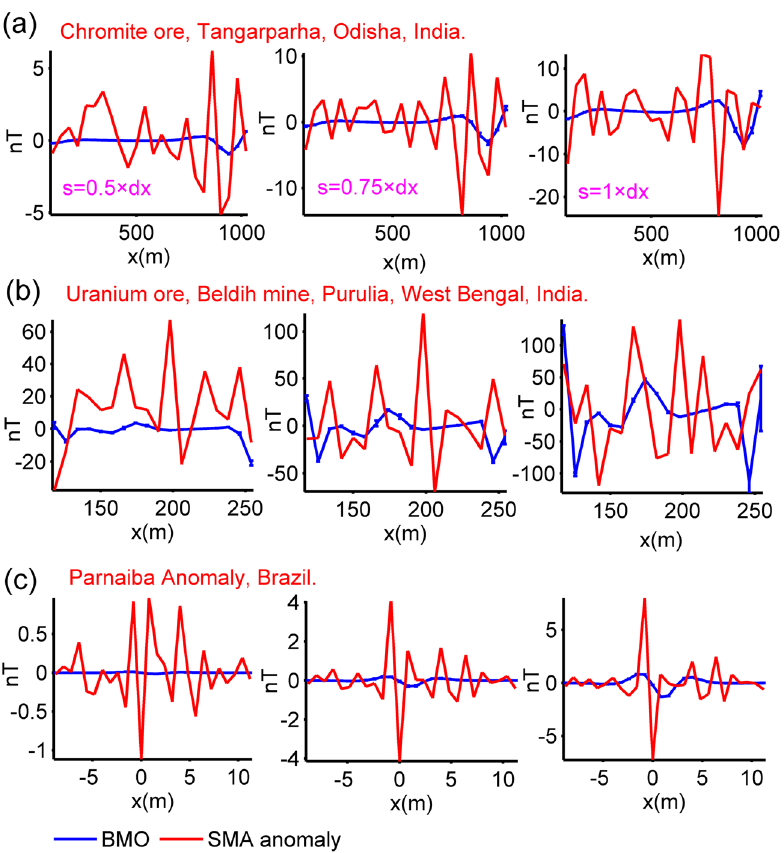
Figure 17. Inversion results of three field cases obtained via BMO with the implementation of the SMA technique, ( a ) the calculated SMA magnetic anomalies of the chromite ore anomaly, India and estimated response of BMO for different s values (0.5, 0.75, and 1 × dx, dx = 40 m), ( b ) the calculated SMA magnetic anomalies of the uranium ore anomaly, India and estimated response of BMO for different s values (0.5, 0.75, and 1 × dx, dx = 8 m), ( c ) the calculated SMA magnetic anomalies of the Mesozoic dyke anomaly, Brazil and estimated response of BMO for different s values (0.5, 0.75, and 1 × dx, dx = 0.8